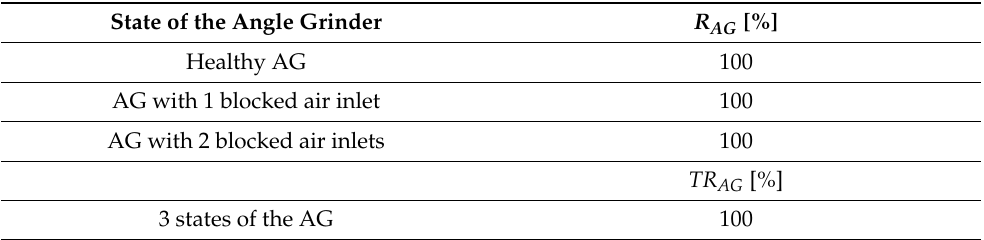
Table 3. Values of TR AG and R AG for using of BCAoMID − F, PCA, and NN classifier. State of the Angle Grinder